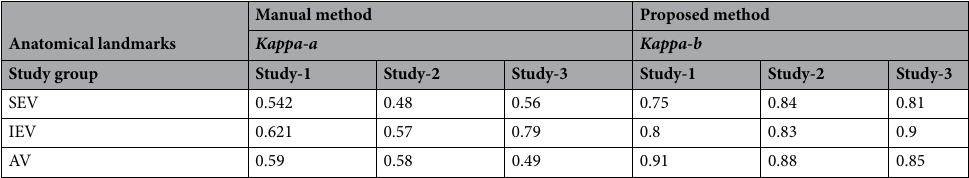
Table 2. Kappa statistic for inter-rater reliability assessment. Kappa-a Interrater variability between observer-1 and observer-2 on pain radiagraph. Kappa-b Interrater variability between observer-1 and observer-2 on CSA and MA extracted radiograph.